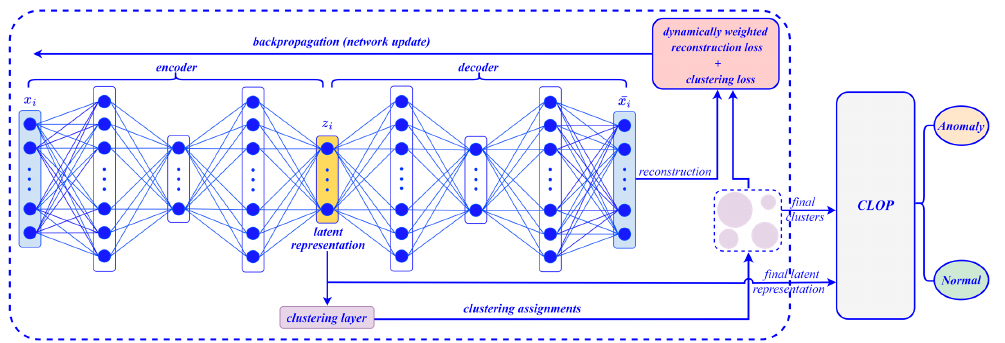
Figure 2. The workflow of the proposed DCLOP